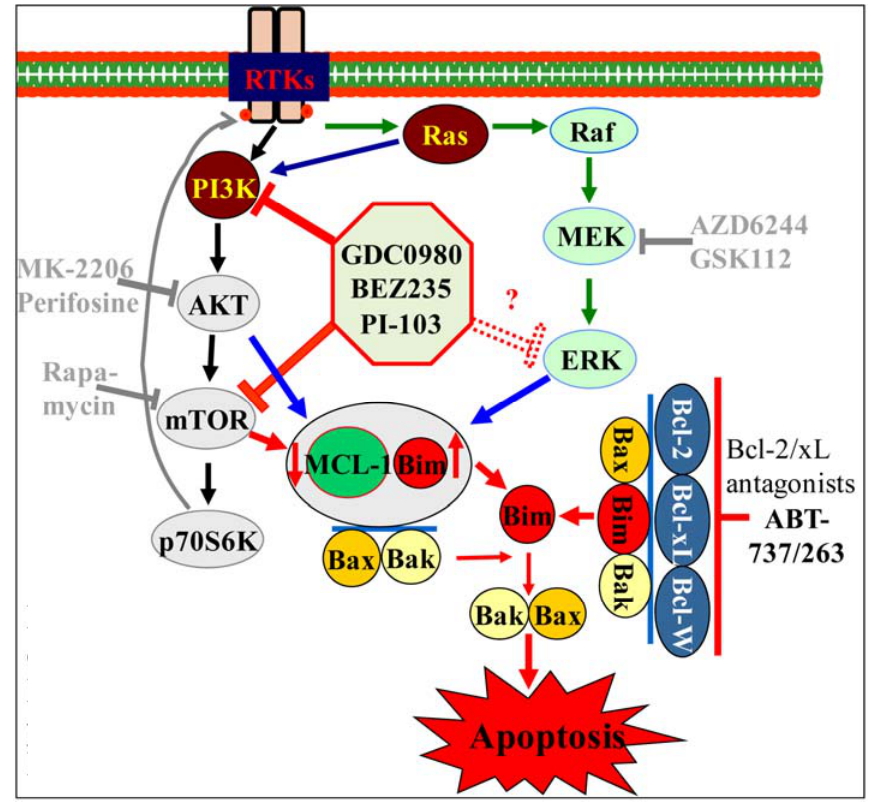
Figure 3. Hypothetical model of interactions between PI3K/AKT/mTOR pathway inhibitors and Bcl-2 antagonists. Reproduced, with permission, from